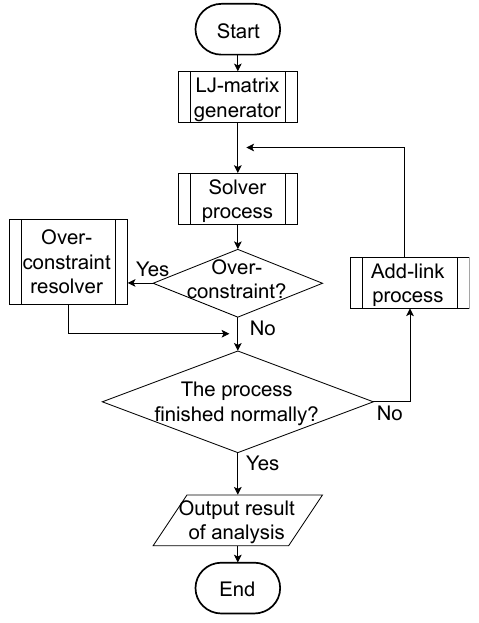
Figure 9. Systematic kinematic analysis algorithm for planar linkage.